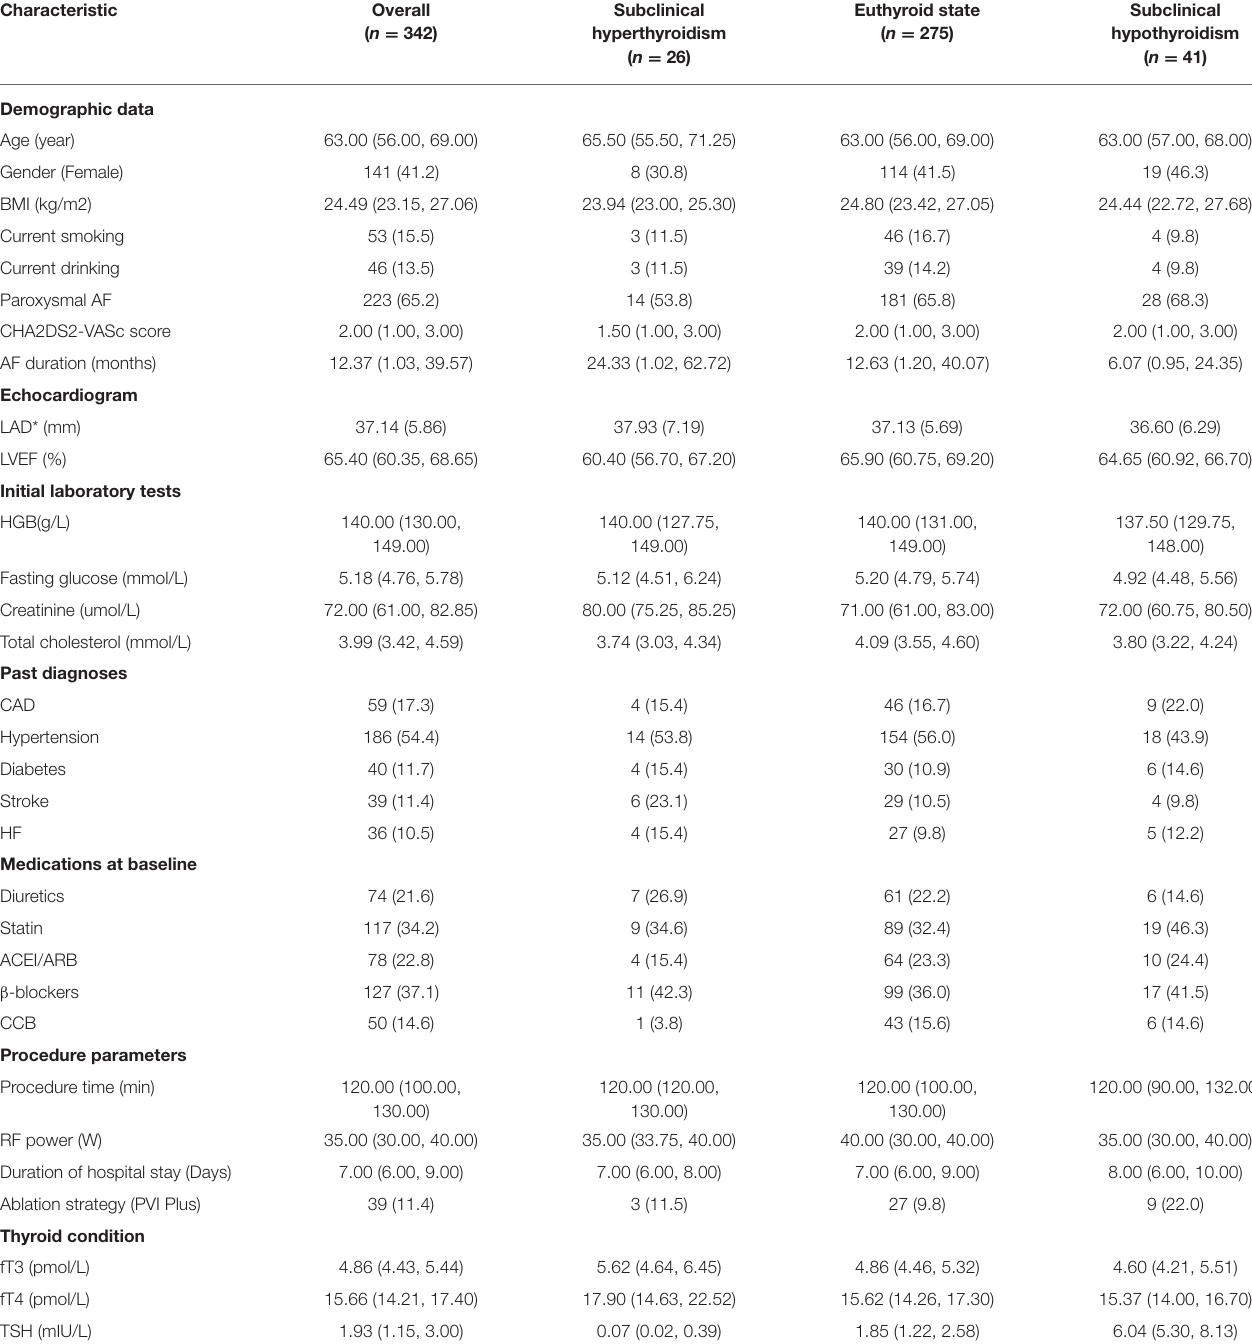
TABLE 1 | Baseline characteristics of included participants stratified by thyroid